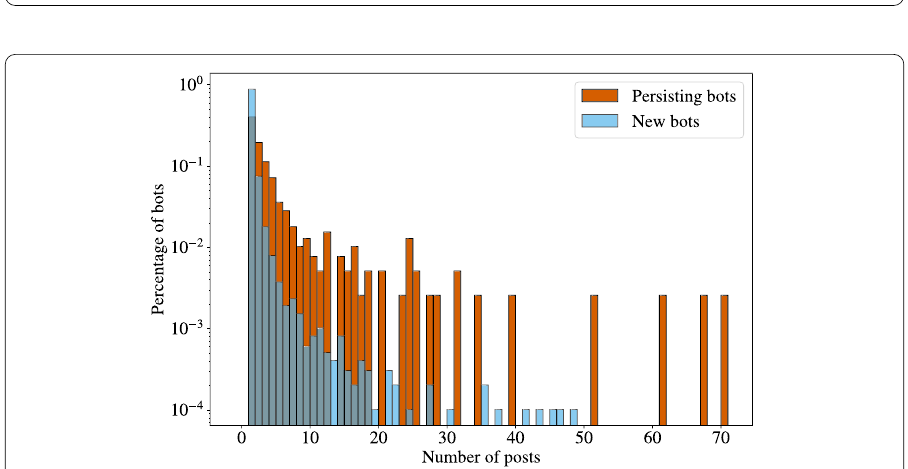
Figure 11 Average values of participation score by category. There is a sudden change of behaviour of bots after the election day in both the presence and participation score: in fact, the average values of the score are almost always higher for bots than for suspended users after the 12th of December. At the same time, the participation score of suspended accounts is always higher than average users before the election day, dropping to much lower levels after the elections